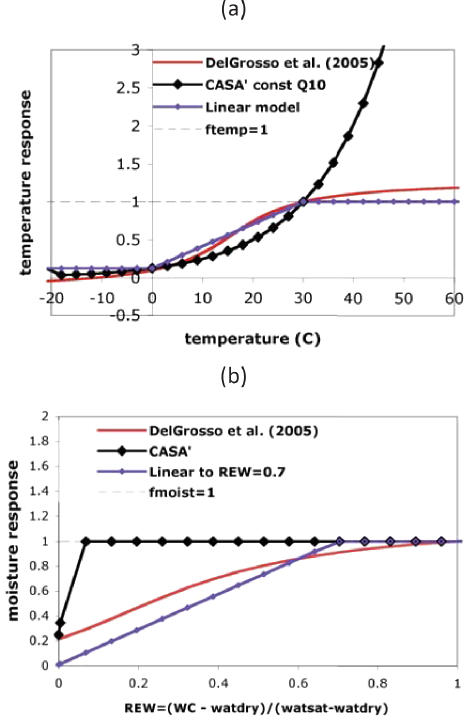
Figure B2. (a) Temperature responses of soil respiration in Del Grosso et al. (2005), CASA’ and Ent’s piecewise linear response; and (b) moisture response of soil respiration in Del Grosso et al. (2005), CASA’ and Ent for grassland (Vaira Ranch) soil texture.